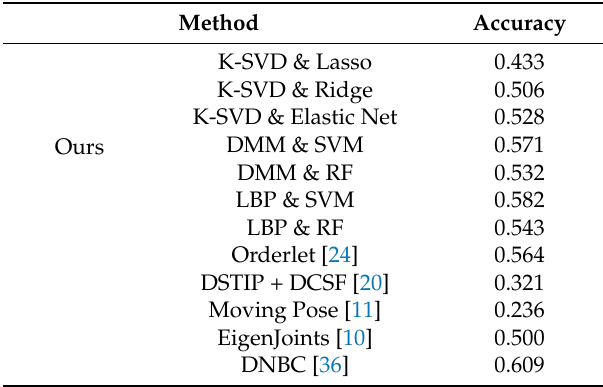
Table 2. Comparison on the MSR 3D Online Action